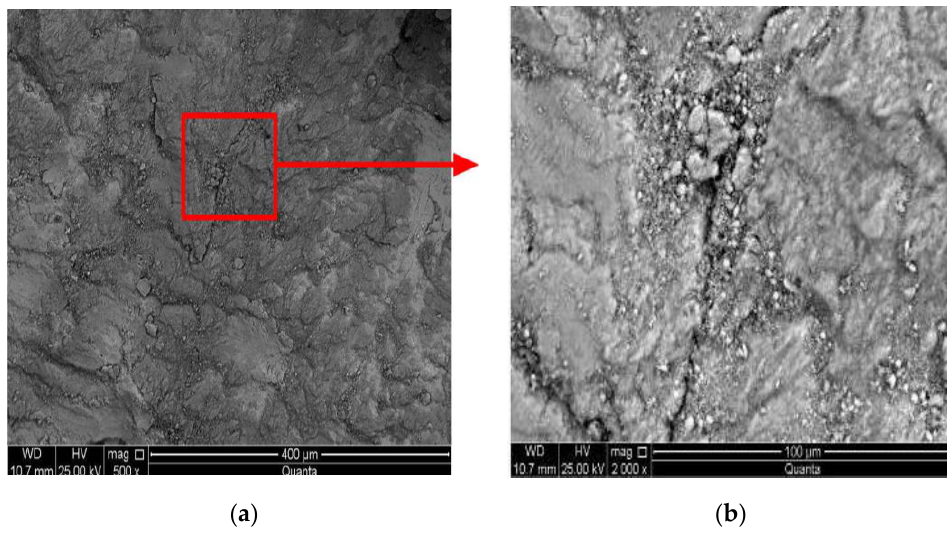
Metals 2016 , 6 , 312 Figure 8. SEM (scanning electron microscopy) images of fracture surface for the STH specimens (load level of 35%). ( a ) Fracture surface of the rivet; ( b ) Enlarged fracture area.